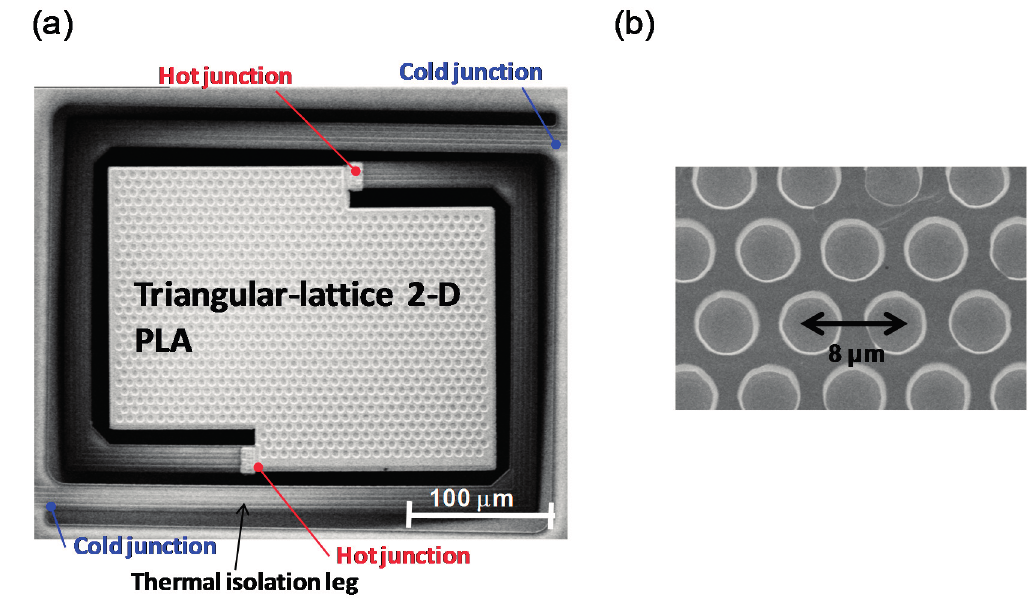
Figure 4. SEM image of ( a ) thermopile with triangular lattice 2-D PLA and ( b ) magnified image of the triangular lattice 2-D